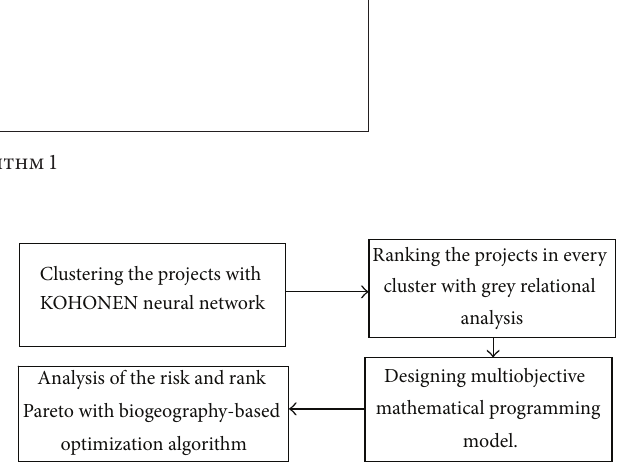
Figure 5: A framework for project portfolio selection using the hybrid model of biogeography-based optimization algorithm and the grey relational analysis based KOHONEN